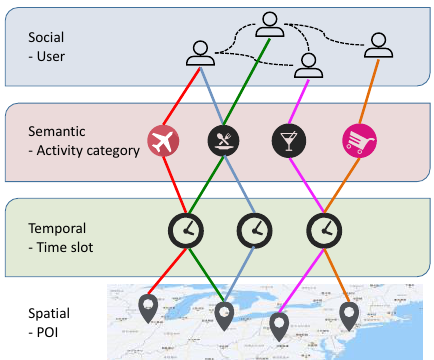
Figure 4. Position-based heterogeneous hypergraphs of social networks [52]. The black dashed lines in the figure indicate user–to–user friendship links, and the bold colored lines indicate the links between the users who checked in, the type of